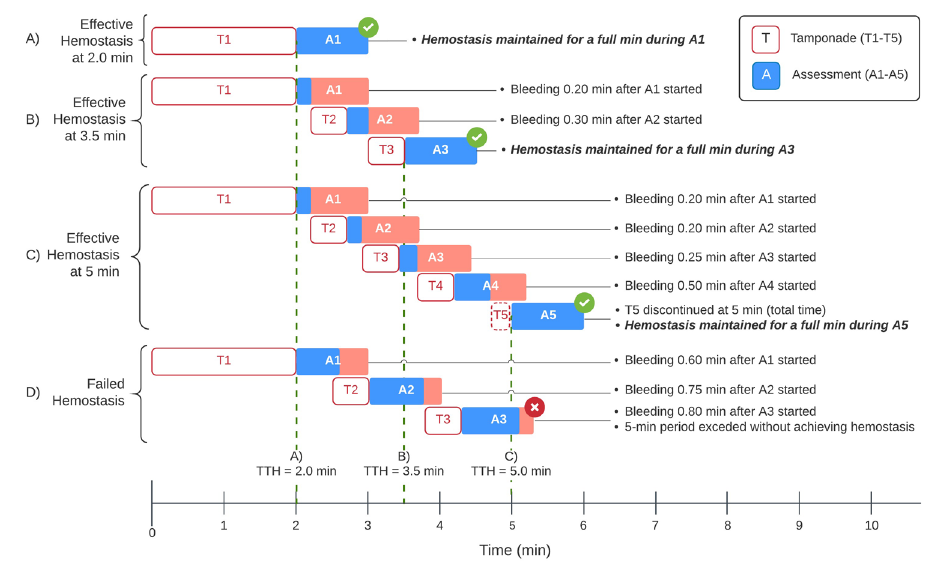
Fig. 2 Sequence of tamponade (T) and visual assessment (A) periods after a randomly assigned product (Surgi fl o or Hemoblast) is applied on an experimentally created biopsy defect. Three representative examples of effective hemostasis ( A – C ) and one of failed hemostasis ( D ) are depicted. While T1 is consistently applied for 2 min, each subsequent T period (T2 – T5) lasts 0.5 min. Each A period may last up to 1 min. Only untreated, control defect sites received 6 T (not shown). Effective hemostasis was achieved and recorded as time to hemostasis (TTH) at 2, 3.5 and 5 min in the 3 examples shown (A, B and C,